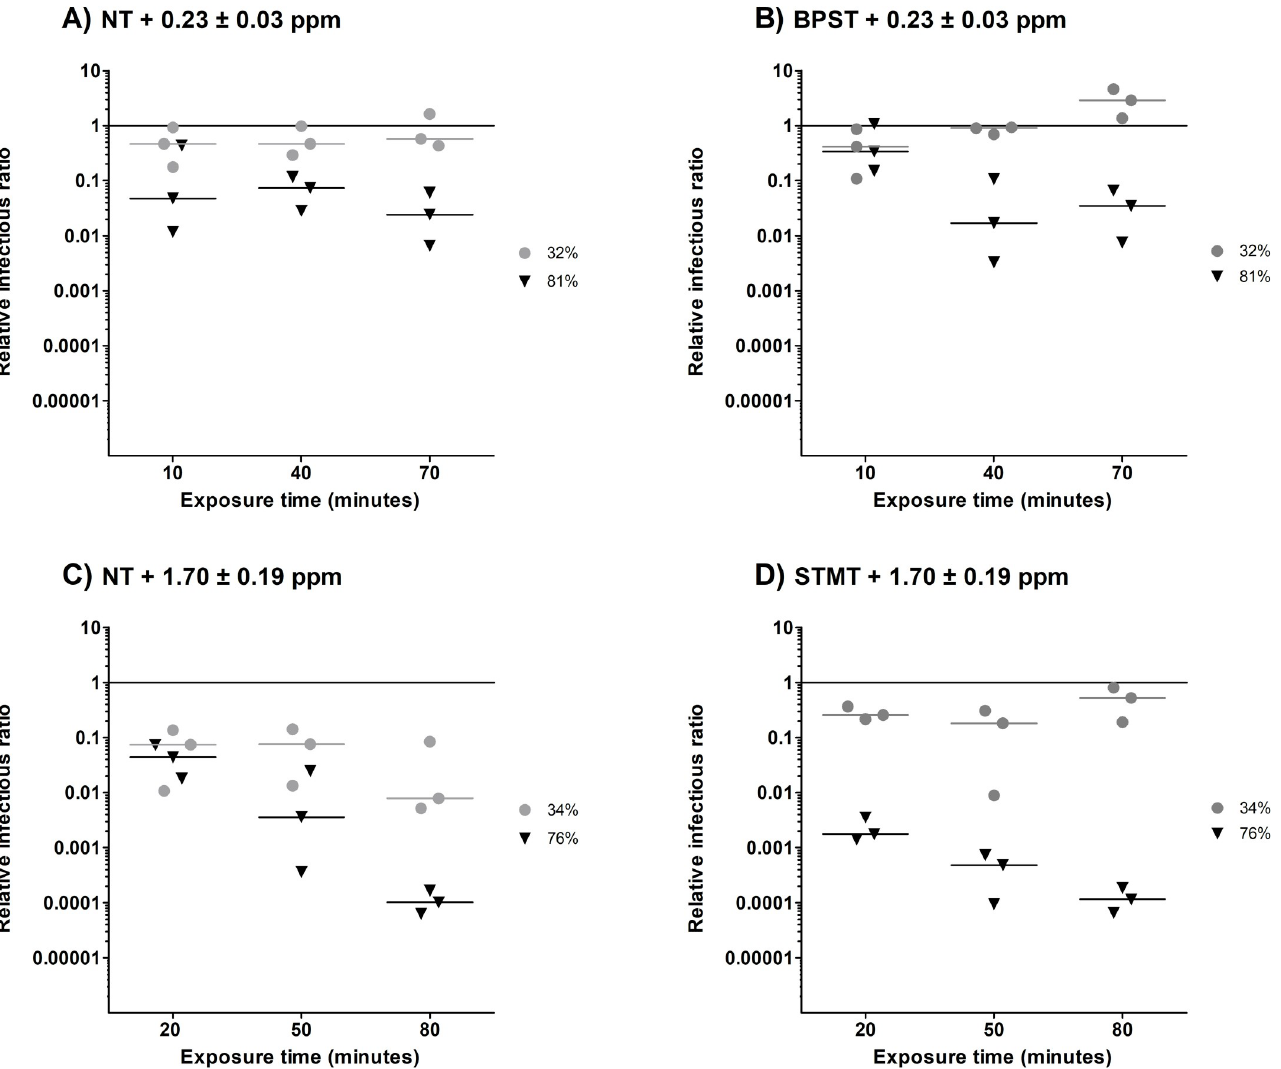
Fig 3. The effect of ozone on influenza A infectivity at two Relative Humidity (RH) levels and three exposure times. The reference value (Fig 2) is represented by a solid line. Grey circles ( ● ) represent low RH values (32 or 34% RH) and black triangles ( ▼ ) represent high RH values (76 or 81%). A) No treatment (NT) and exposed to 0.23 ± 0.03 ppm of ozone, B) 10% bovine pulmonary surfactant (BPST) and exposed to 0.23 ± 0.03 ppm of ozone, C) NT and exposed to 1.70 ± 0.19 ppm of ozone, and D) 10% synthetic tracheal mucus (STMT) and exposed to 1.70 ± 0.19 ppm of ozone.